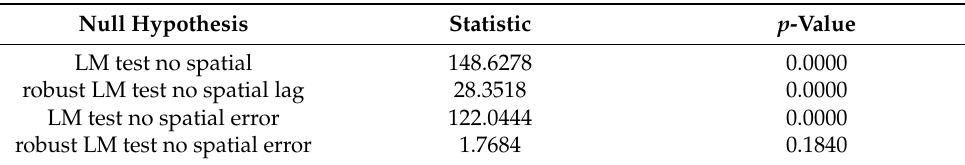
Table 2. Results of Lagrange Multiplier statistics test.